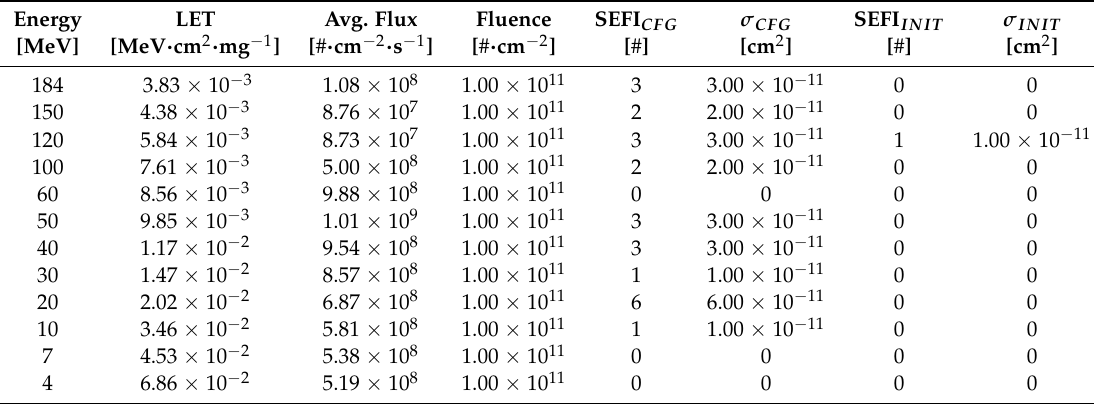
Table 10. SEFI rate for DUT Sample